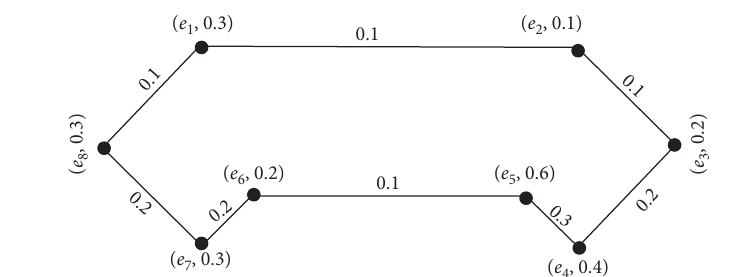
Figure 21: Fuzzy graph G � ( J , K )